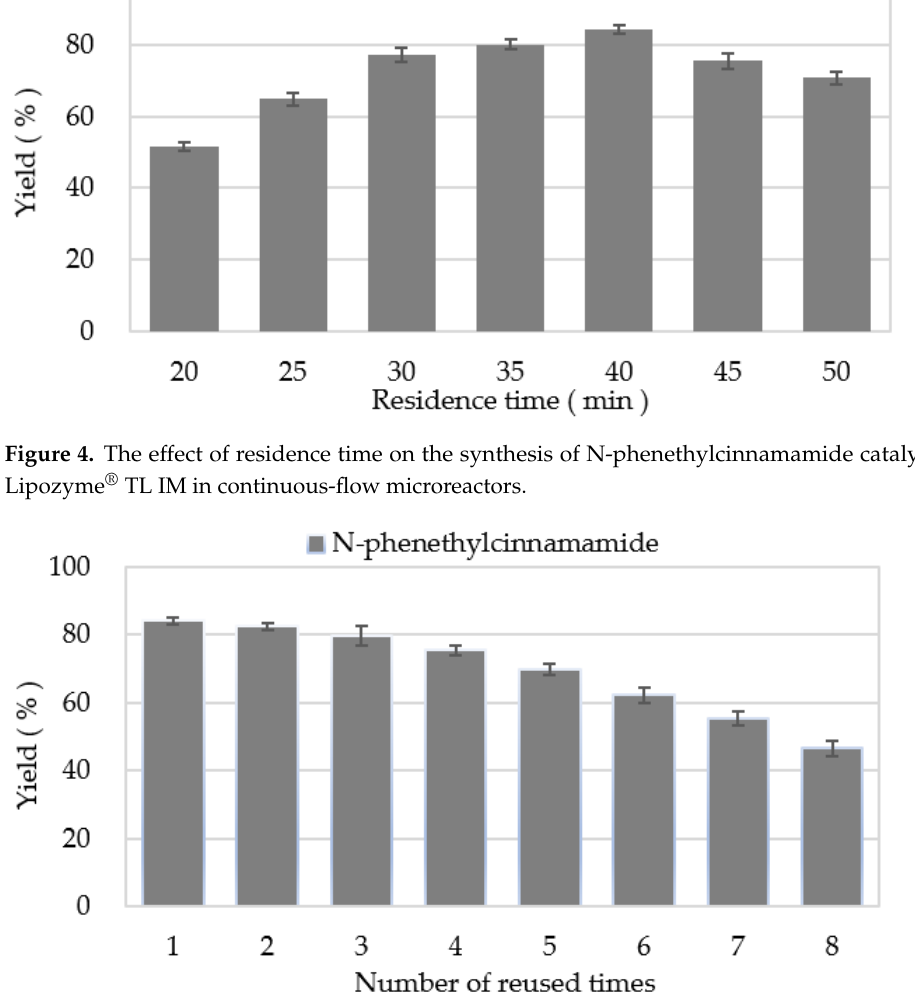
Table 2. Enzyme-catalyzed synthesis of N-phenethylcinnamamide in a Continuous-Flow Microre- actor or a Batch Bioreactor a .